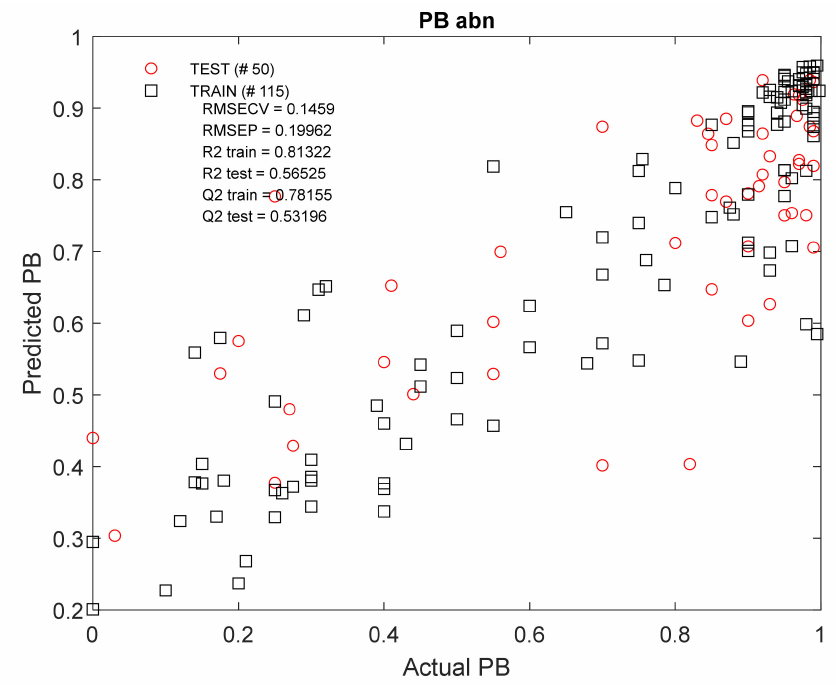
Figure A4. Actual versus predicted PB abn values, using RF regression modelling of molecular descriptor set containing 22 variables along with HPLC HSA data. RMSE CV = root-mean-square error of cross-validation, RMSE P = root-mean-square error of prediction, R 2 train/test = coefficient of determination for train/test set models, Q 2 train/test = coefficient of determination for the cross- validated models.